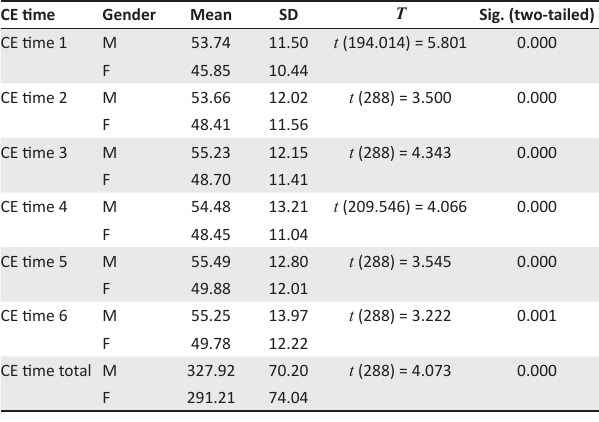
TABLE 3: Independent samples T -test: Comparison of time scores for males ( n = 198) and females ( n = 92) on the H letter cancellation test. H time